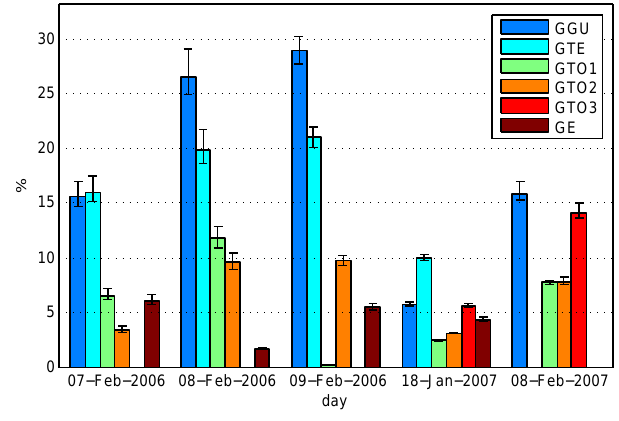
Fig. 9. Maximum hourly contribution of glacier meltwater to VIT3 discharge (error bars account for the uncertainty on discharge travel